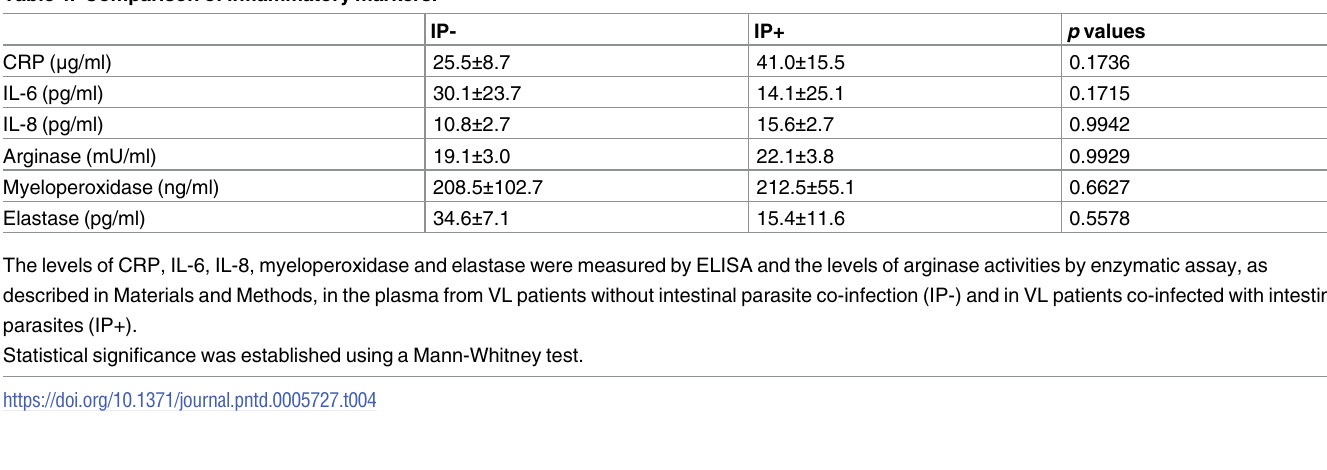
Table 4. Comparison of inflammatory